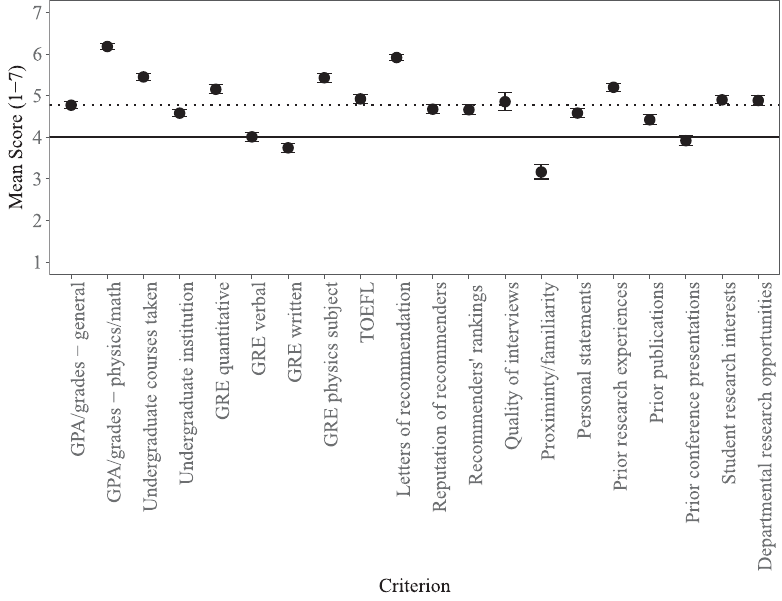
FIG. 1. Mean importance assigned to each admission